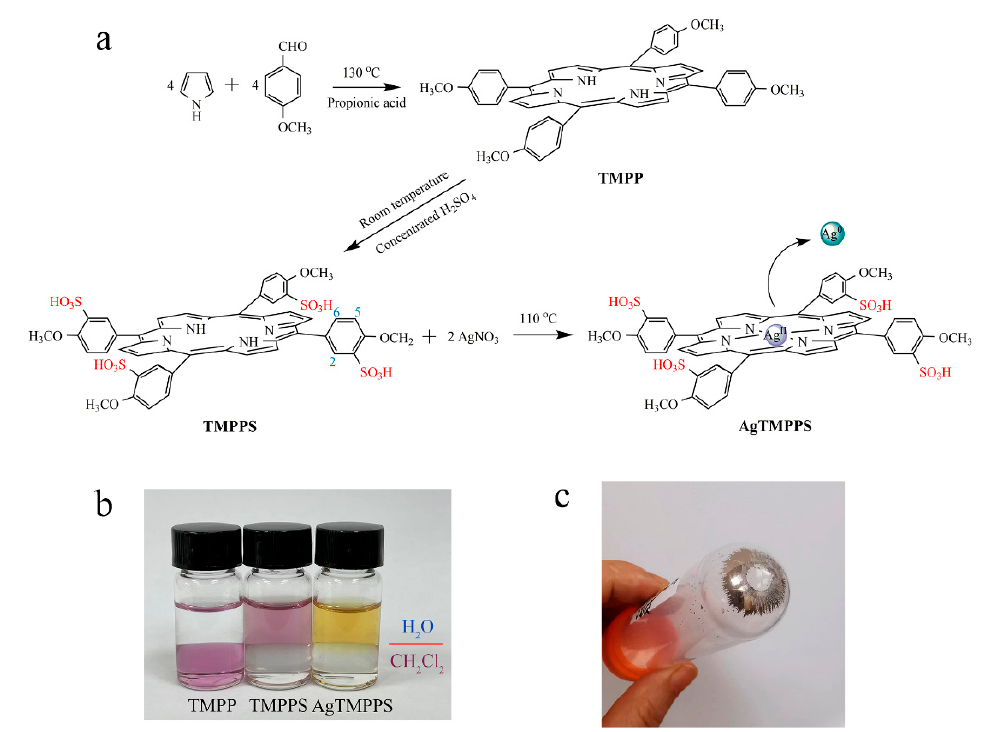
Figure 1. Synthesis of the silver-based porphyrin. ( a ) Schematic illustrating the fabrication of Ag-TMPPS. The numbers represent the positions of protons. ( b ) Solubility of porphyrins in two-phase media (H 2 O/CH 2 Cl 2 ). ( c ) Precipitate after centrifugation of the reaction suspension.